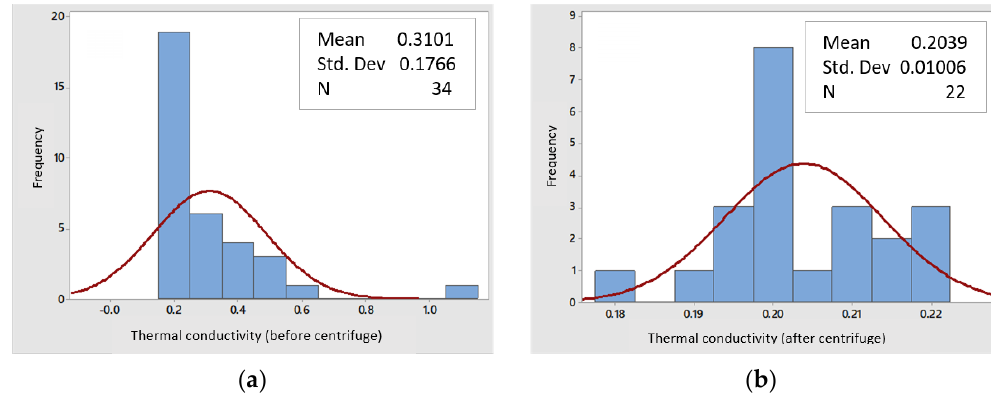
Figure 11. Thermal conductivity of SiO 2 NPs ( a ) before and ( b ) after the separation process.